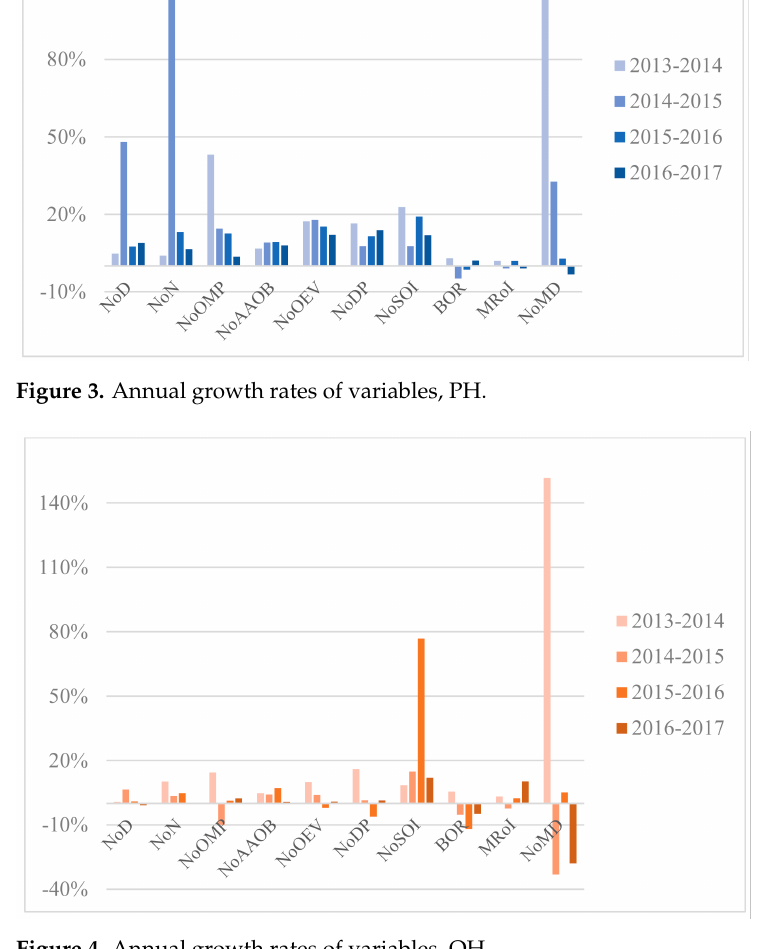
Figure 4. Annual growth rates of variables, OH.